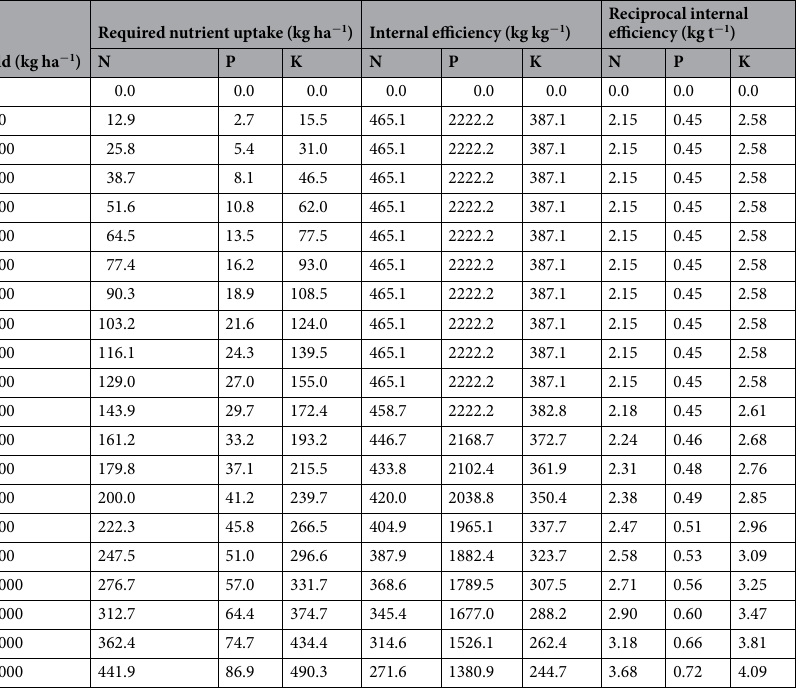
Table 4. Balanced nutrient uptake requirements, internal efficiencies (IE, kg fleshy root per kg nutrient), and the reciprocal internal efficiencies (RIE, kg nutrient per 1000 kg fleshy root) of N, P, and K simulated by